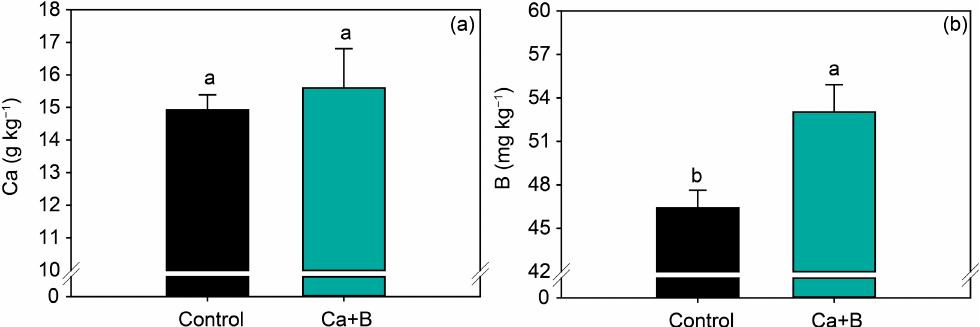
Figure 2. Soybean leaf levels of calcium (Ca) ( a ) and boron (B) ( b ) as a function of foliar application of Ca + B. Different lowercase letters indicate a significant difference between Ca + B treatments by Fisher’s test ( p ≤ 0.05). Error bars express the standard error of the mean ( n = 12).